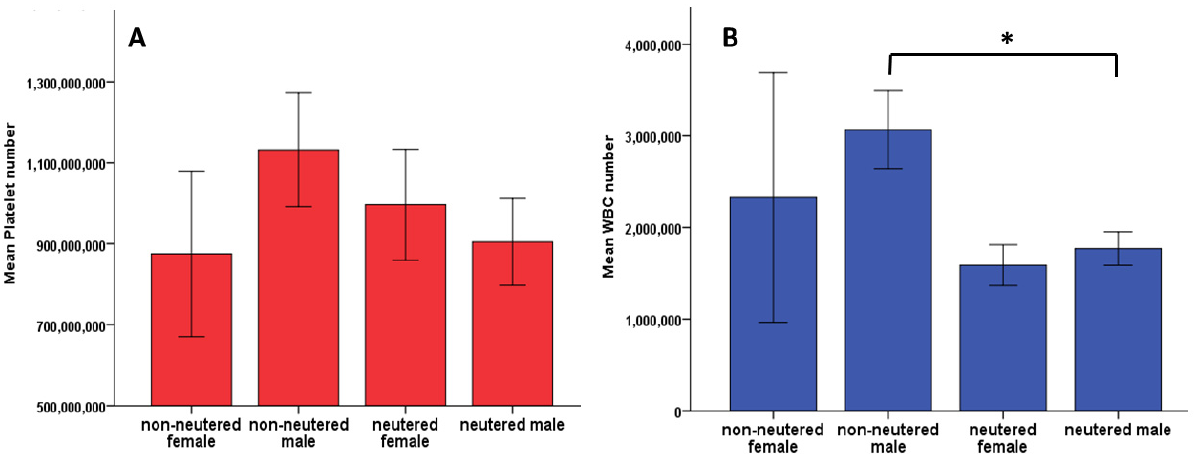
Figure 5. Student’s t -test showed no statistical difference between patient’s neutered status and platelet number ( p = 0.765) ( A ). However, there was a significant difference in WBC number between neutered and non-neutered patients ( p = 0.003), showing increased number in the non-neutered male group ( B ). * represents significance p < 0.05. Error bars represent ± 1 Standard error.